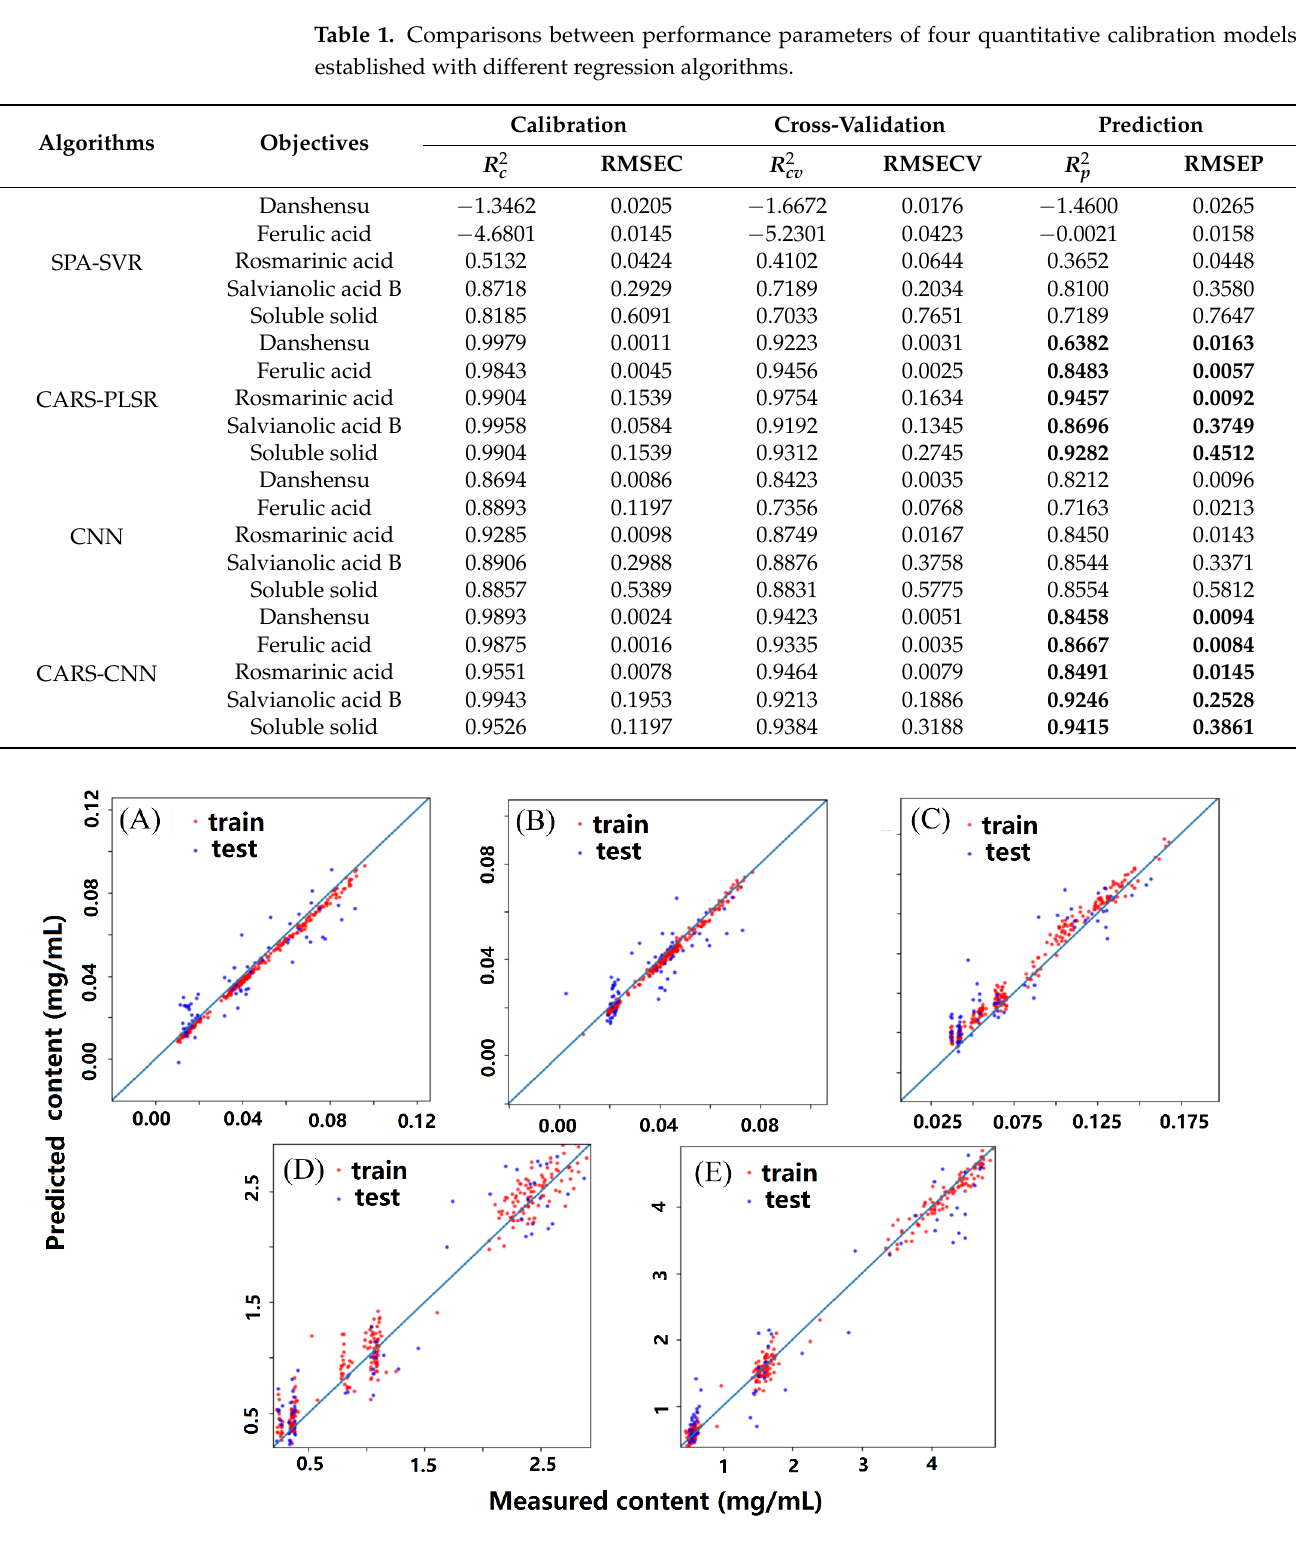
Figure 6. Correlation diagram of predicted values and measured values of the five attributes: ( A ) danshensu, ( B ) ferulic acid, ( C ) rosmarinic acid, ( D ) salvianolic acid B, and ( E ) soluble solid.